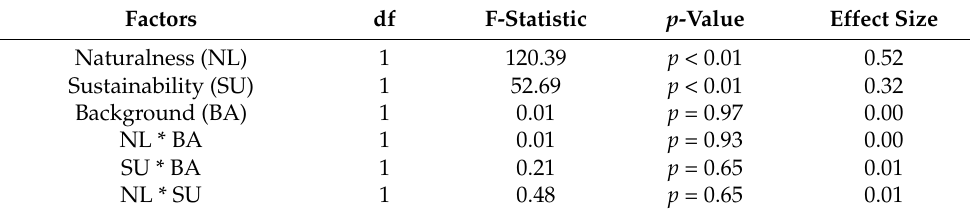
Table 4. Summary of the main effects and interactions of eco-friendliness.